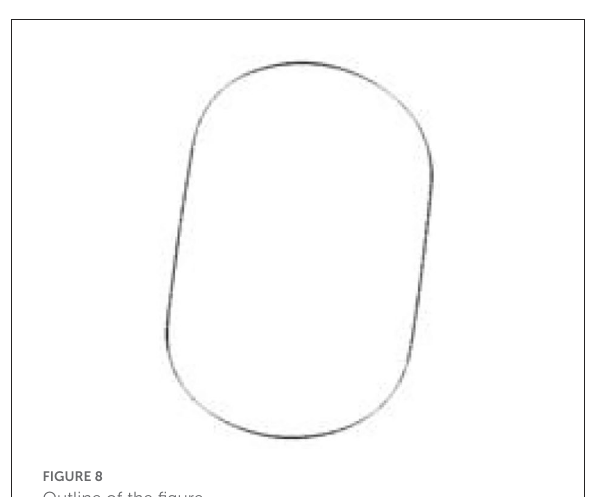
FIGURE8 Outline of the